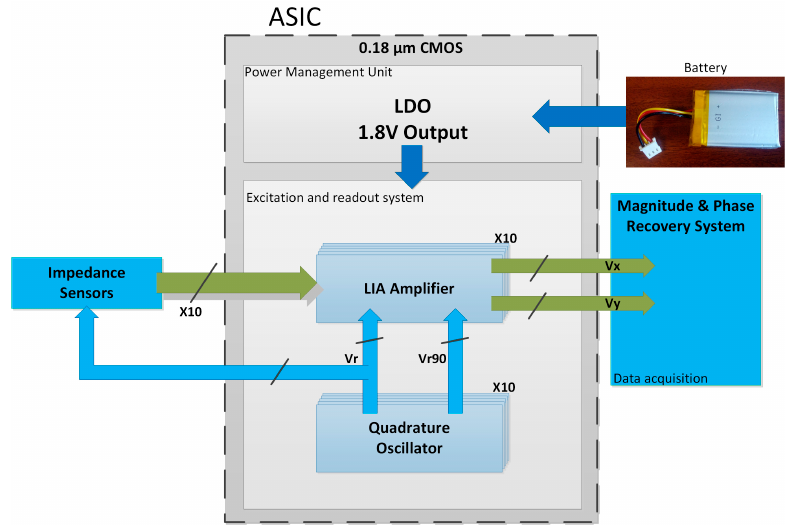
Figure 1. Multichannel Lock-In Amplifier-based (LIA) System on Chip (SoC) portable instrument.